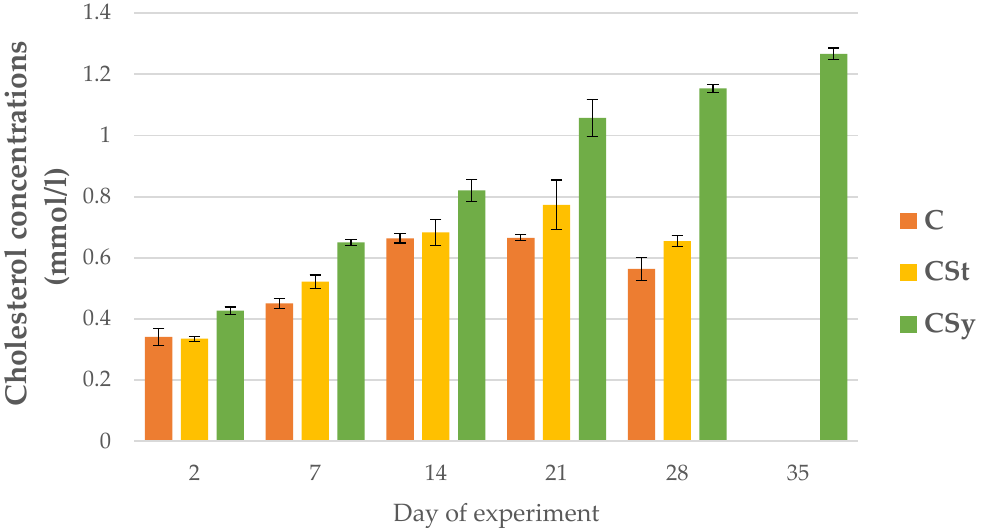
Figure 13. Cholesterol concentrations in 2, 7, 14, 21, 28, 35-day-old workers’ hemolymph after two methods of supplementation with hemp extract: C-control (pure sugar syrup), Csy-hemp extract in syrup, Cst-hemp extract on strips. Two-Way ANOVA: supplementation method: F (2, 156) = 44.905, p = 0.0000, se ± 0.027850–0.030509; days of supplementation: F (4, 143) = 997.34, p = 0.0000, se ± 0.006106–0.010575; supplementation method × days of supplementation F (8, 143) = 107.76, p = 0.0000, se ±